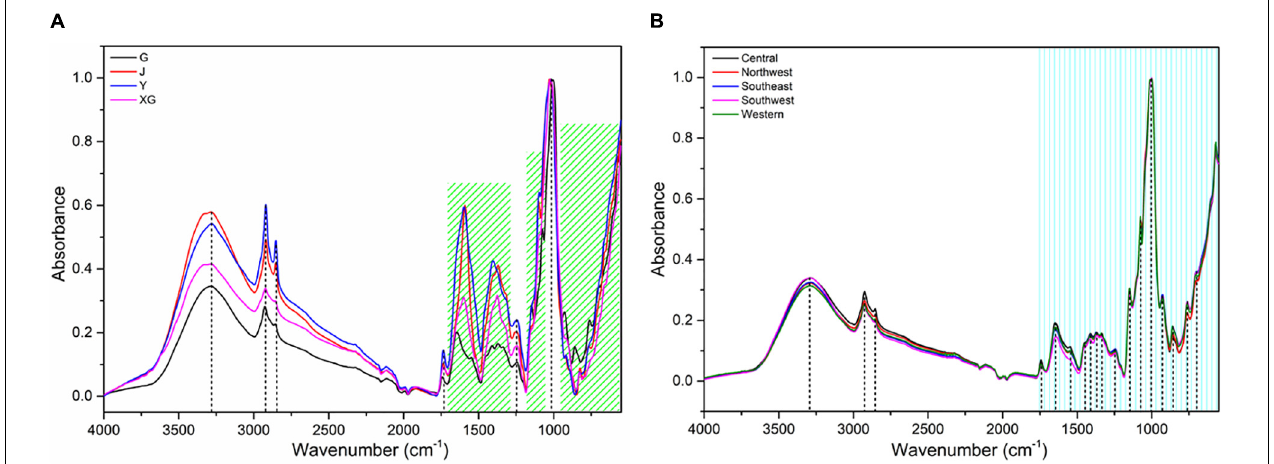
FIGURE 3 | Averaged raw spectra of Paris polyphylla var. yunnanensis. (A) parts; (B) regions. The G, J, Y, and XG represent the rhizome (G), stem (J), leaf (Y) and fibrous root (XG),